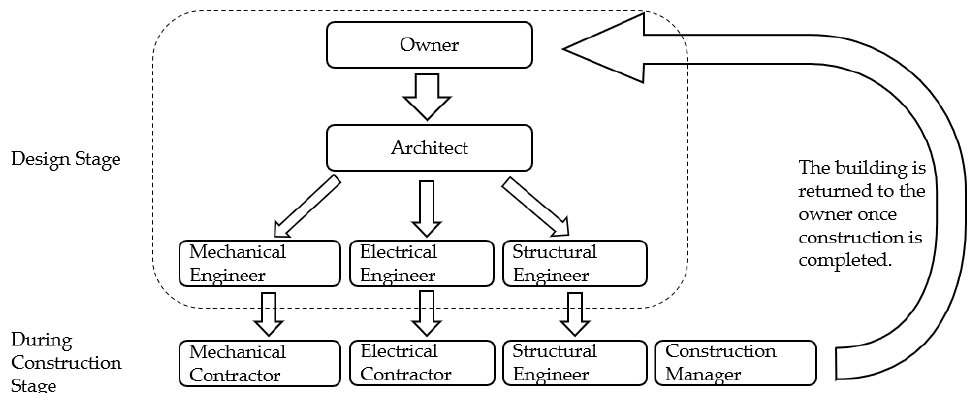
Figure 1. A simple illustration of the general process of the different personnel working in different stages of construction. Overview concept adapted from [20].